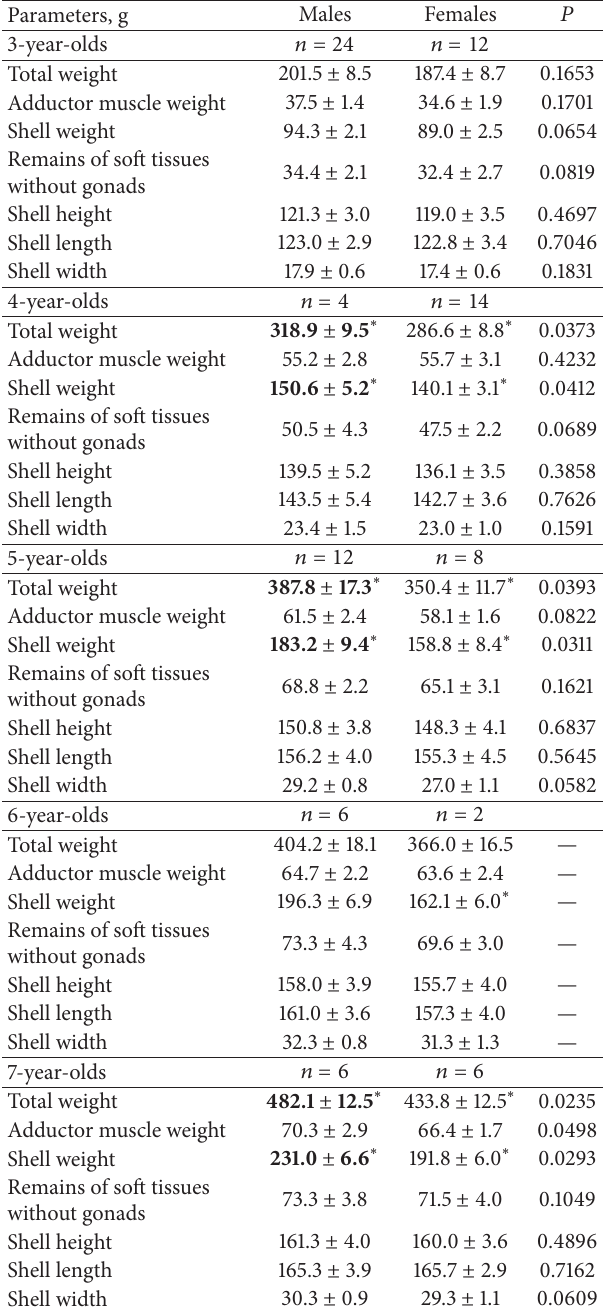
Table 4: Patinopecten yessoensis . Wet weight and size parameters of the same aged males and females from the population inhabiting Zapadnaya Bay of Furugalm Island. ∗ indicates significant differ- ences between parameters at a level 𝑃 < 0.05 ( 𝑡 -test). — indicates that data were not compared. Bold marks higher values. 𝑛 is sample size.